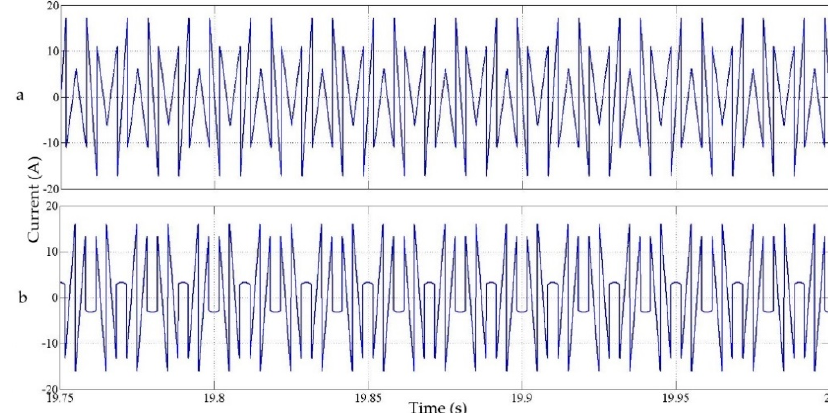
(cid:3080)∗ ; ( b ) (cid:1861) (cid:3081)∗ .